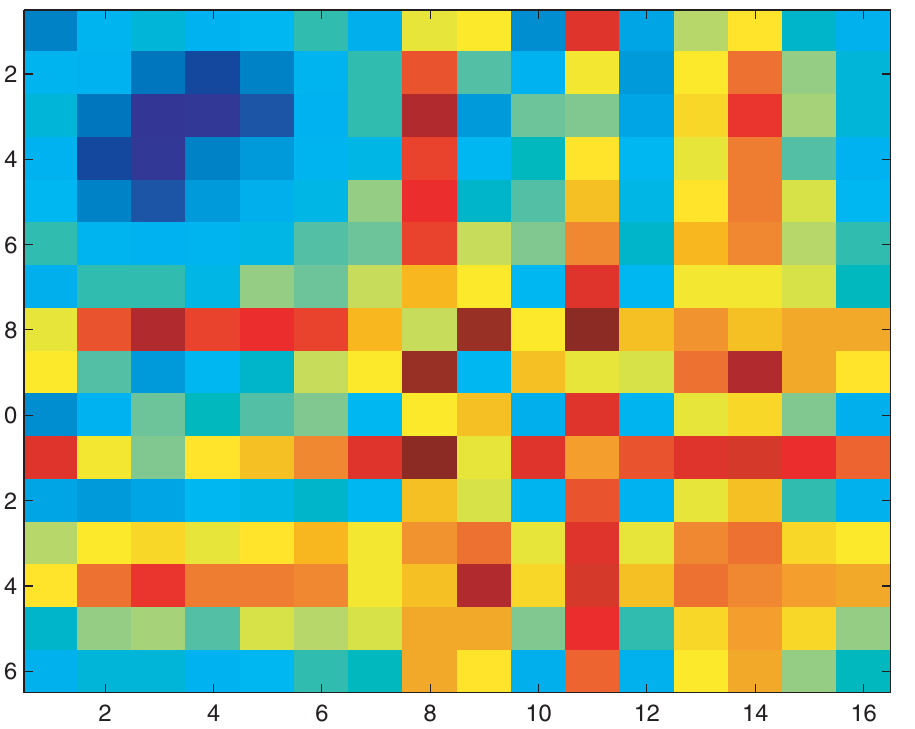
Figure 7. Module composition over unfolding: The plot shows the similarities (differences) in modular composition across the different frames as compared to the composition in the first frame. Each square on the plot represents 0.5 ns. The colors go from blue (similar modular composition) to red (highly dissimilar modular composition). It can be observed that the only region of long-time similarity is in the upper left region which corresponds roughly to about 3 ns, after which the modular compositions become very dissimilar. See text for more details on how the plot was obtained.